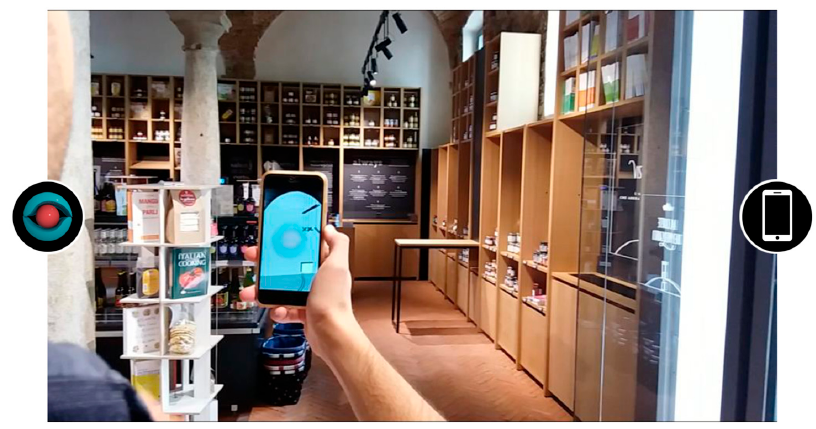
Figure 6. Systems visualization with an augmented reality (AR) media app.